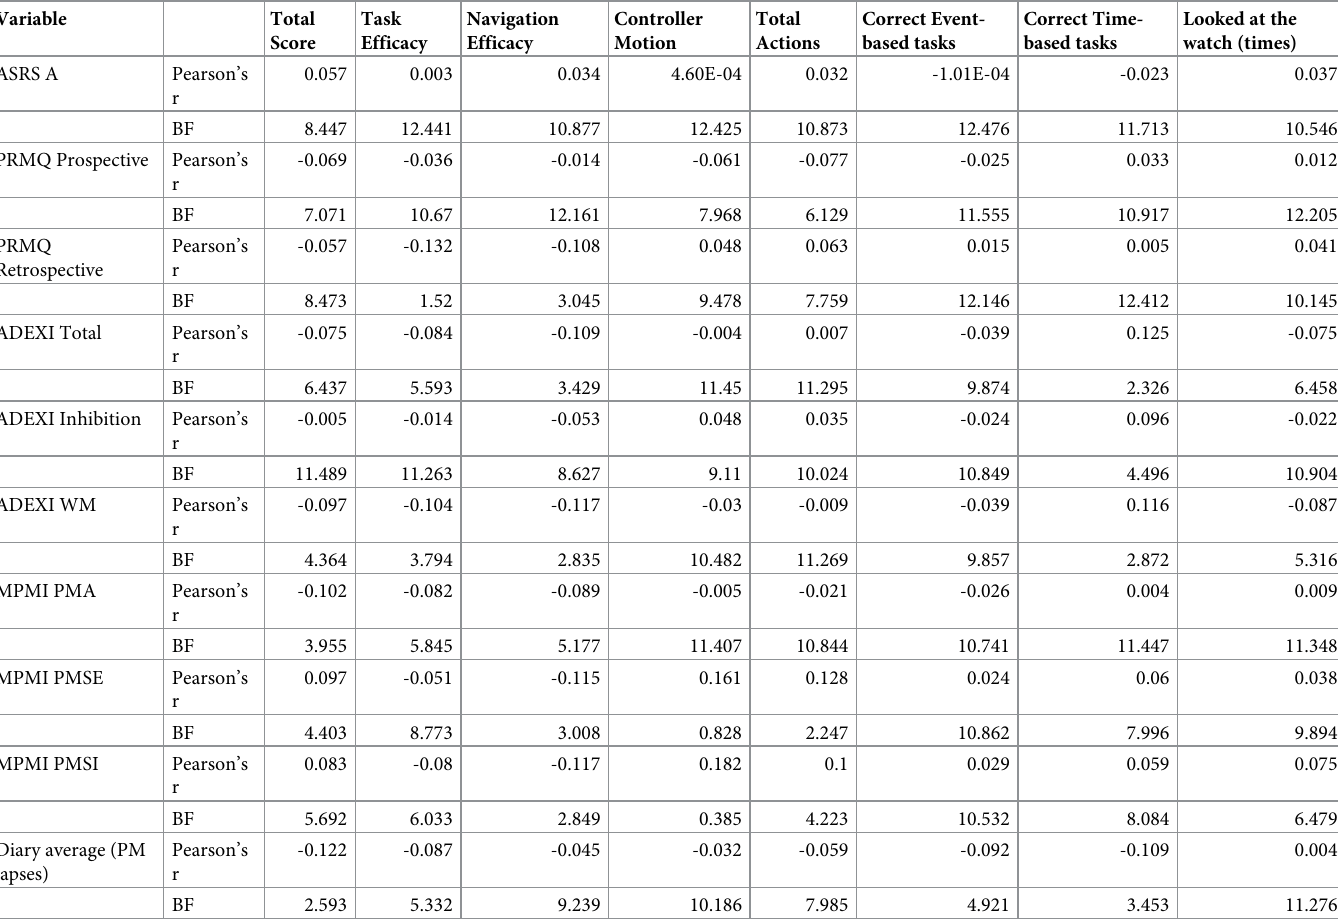
Table 7. Associations between the EPELI variables and the questionnaires and the PM diary. The Bayes Factors reported here are inverted (BF 01 ) and indicate evi- dence for the null hypothesis.